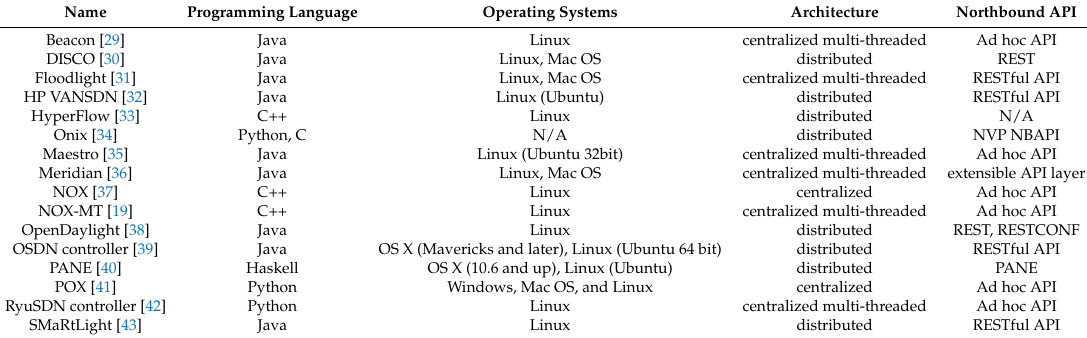
Table 1. SDN controllers with programming language, target operating systems, general architecture and the type of northbound